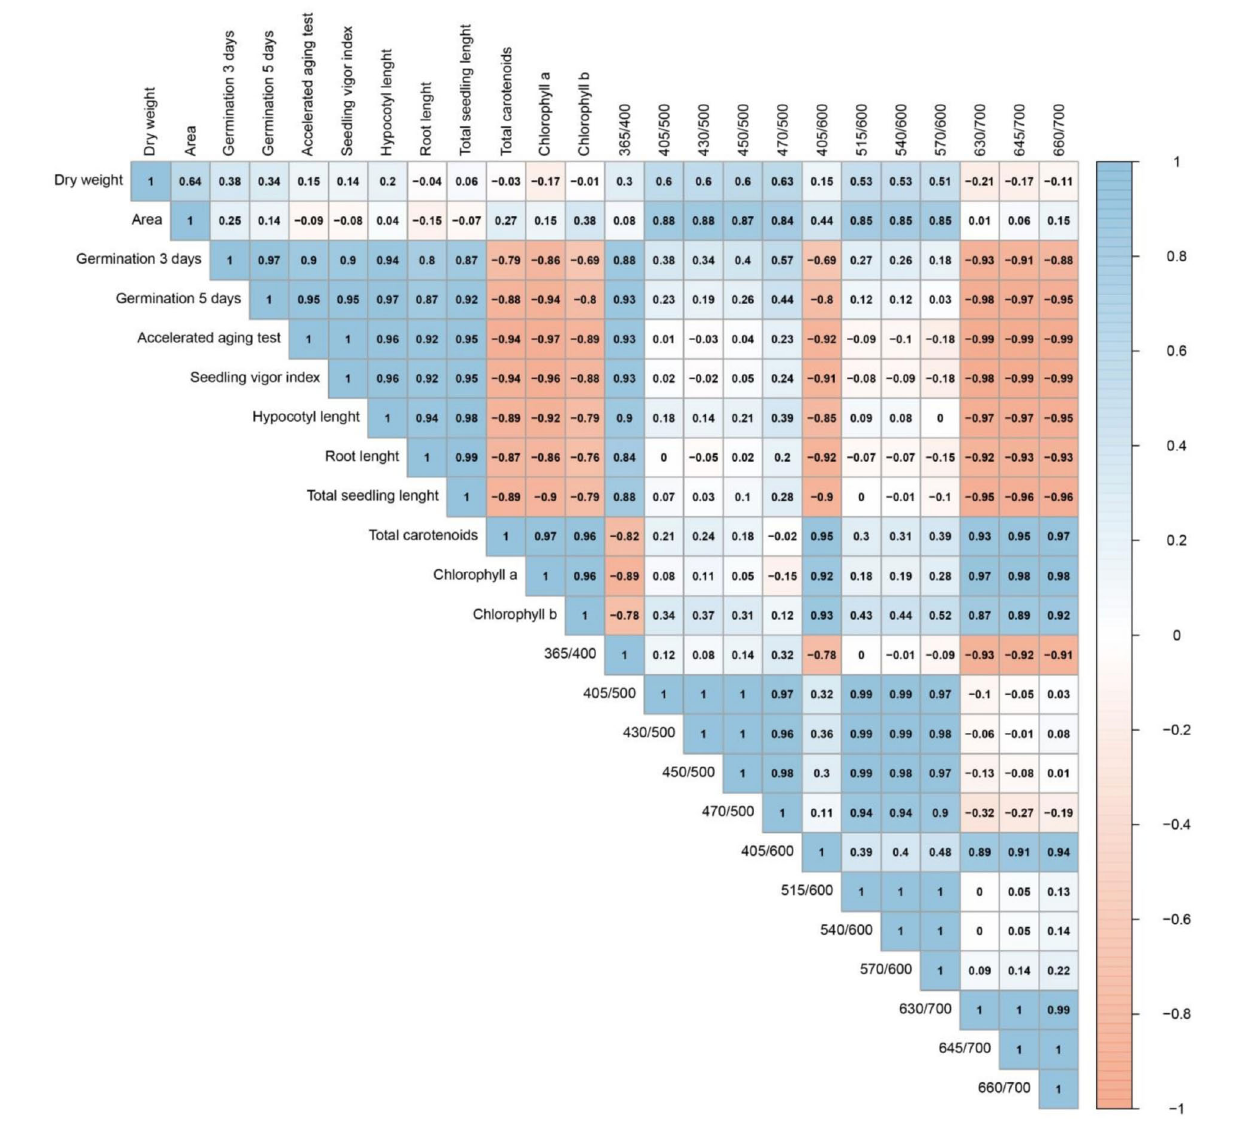
FIGURE 8 | Pearson’s correlation coefficients between physical properties, physiological quality, pigment content and autofluorescence-spectral markers (nm) in soybean seeds of different maturation stages (R7.1, R7.2, R7.3, R8, and